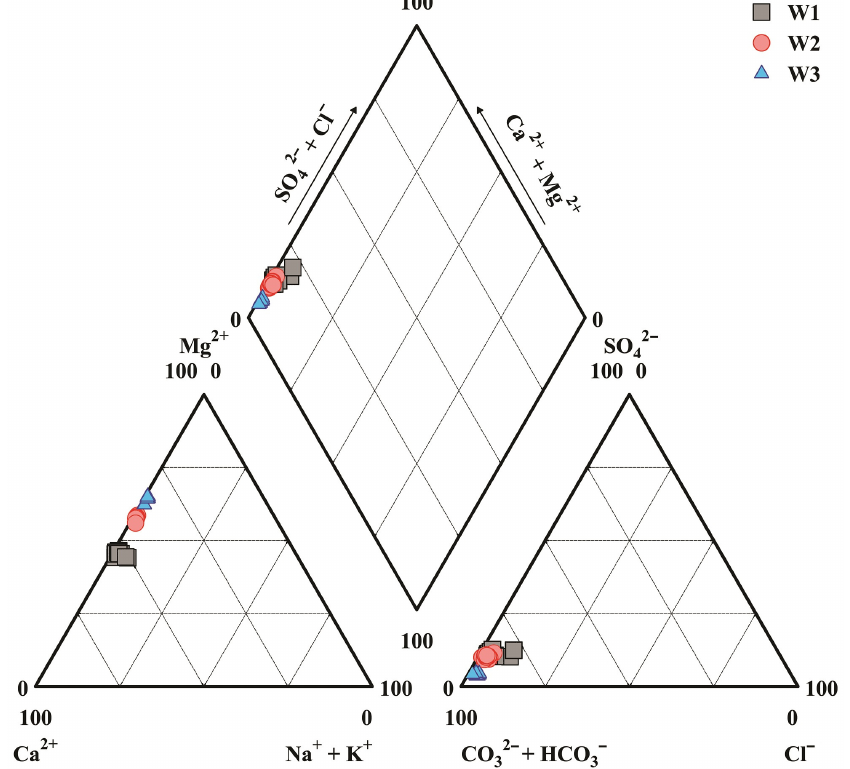
Figure 2. Piper diagram of drip water